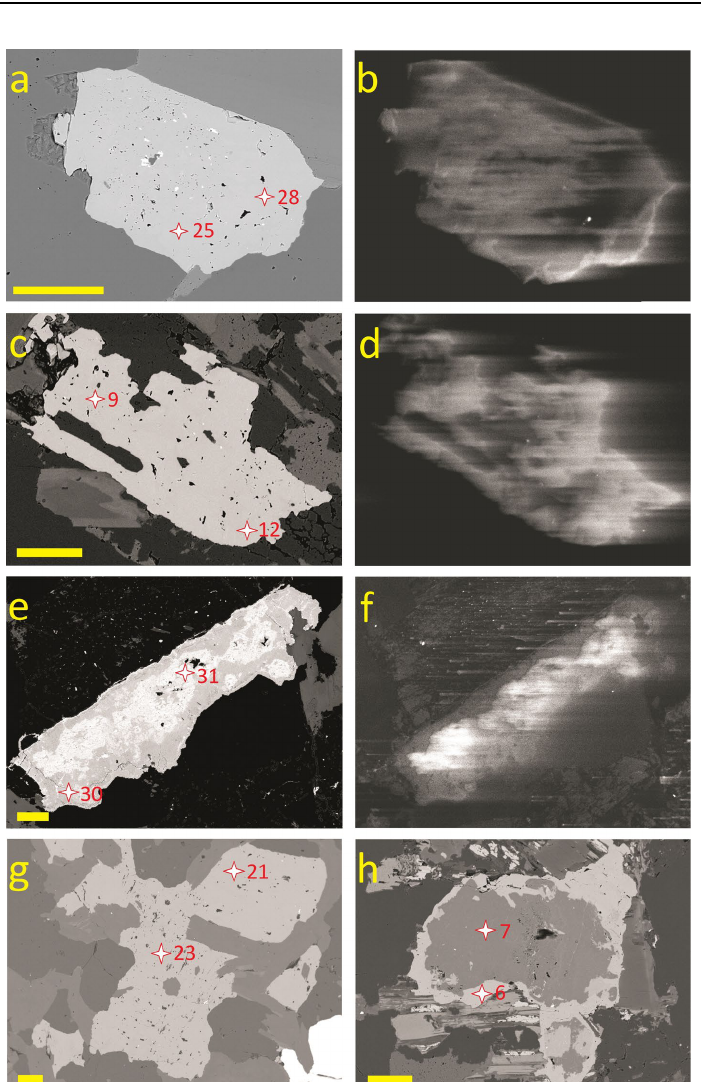
Figure 10. Back-scattered electron images (BSE) and CL images (CL) of typical apatite grains with locations of EMP analyses: ( a , b ) BSE and CL images of an apatite grain from porphyritic granite (#5); ( c , d ) BSE and CL images of an apatite grain from leucocratic granite (#8); ( e , f ) BSE and CL images of an apatite grain from leucogranite (#37), note the strong zoning in both images: core of the grain is enriched especially in Mn; ( g ) apatite grains from greisen (#10); ( h ) a zoned phosphate grain: apatite core is rimmed by isokite (porphyritic granite, #5). Scale bars are 100 μm in all cases. Stars indicate localization of EMP analyzes, compare Table 6.